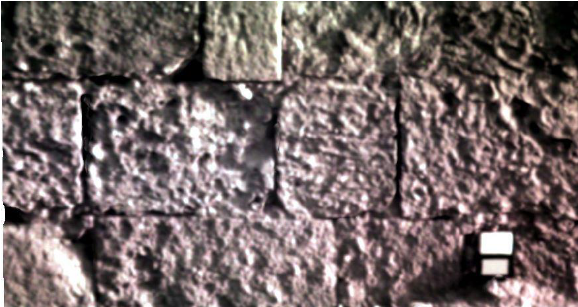
Figure 6 . Detailed 3D Textured Model using HS bands 823 nm, 710 nm, 696 nm as RGB.